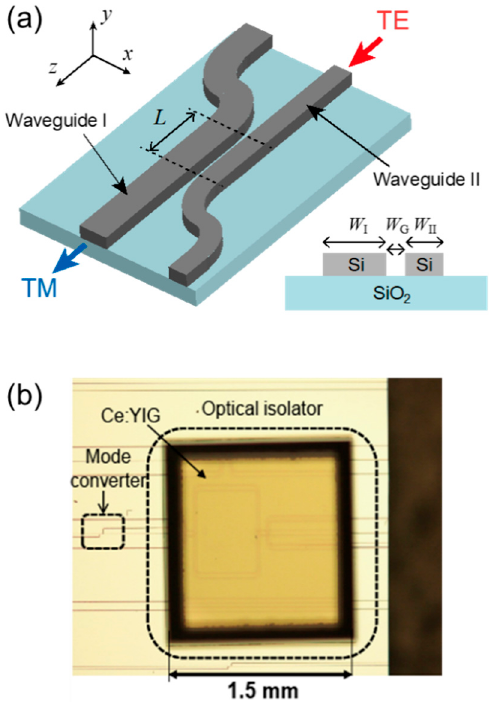
Figure 8. ( a ) Transverse electric (TE)–transverse magnetic (TM) mode converter consisting of two parallel waveguides. ( b ) Microscopic image of fabricated MZI optical isolator integrated with mode